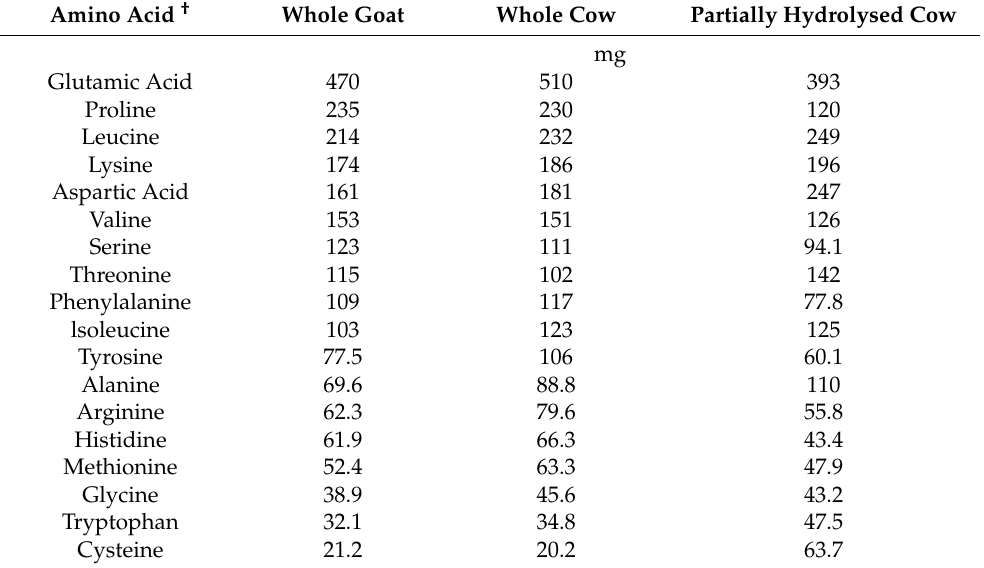
Table 2. Total amino acid profile per 100 mL prepared fortified milk. Whole Goat Whole